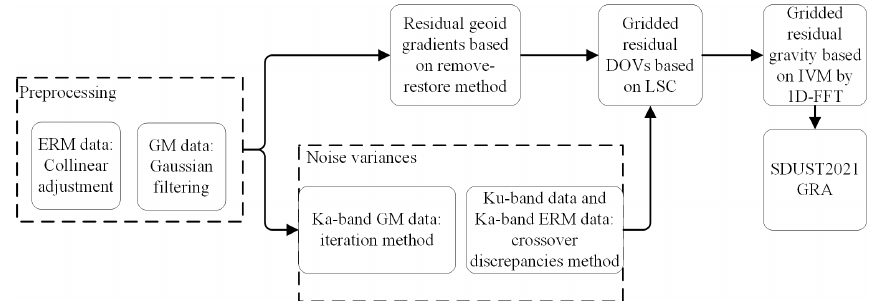
Figure 4. Method for establishing ocean gravity anomaly model from multi-satellite altimeter